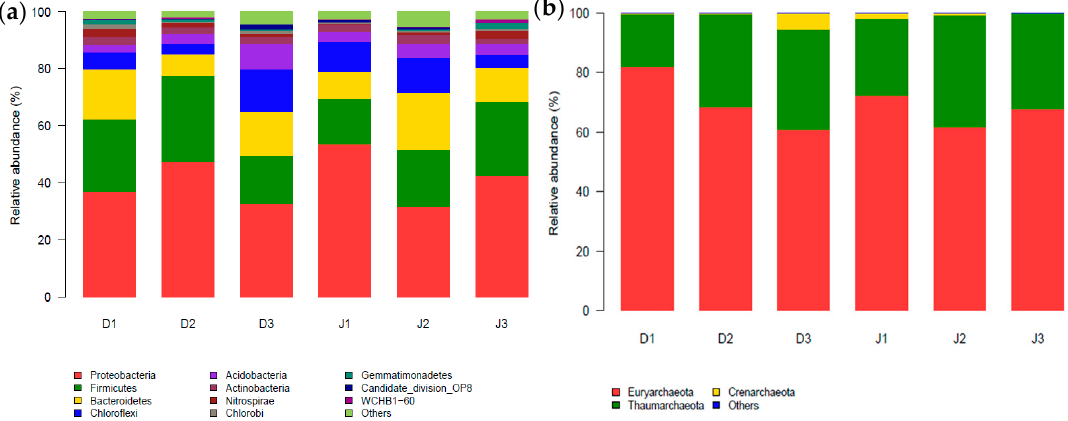
Figure 2. Phylum distribution of sediment bacteria ( a ) and archaea ( b ) in the creeks (with relative abundance >1%).